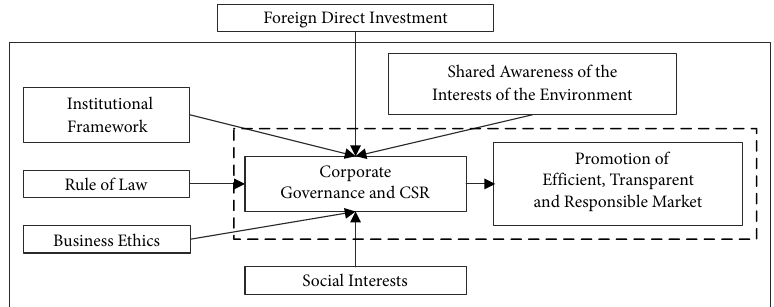
Figure 1. Institutional and other factors having impact on CG and CSR (source: created by authors based on Jonker, 2005; Draskovic & Stjepcevic, 2012)